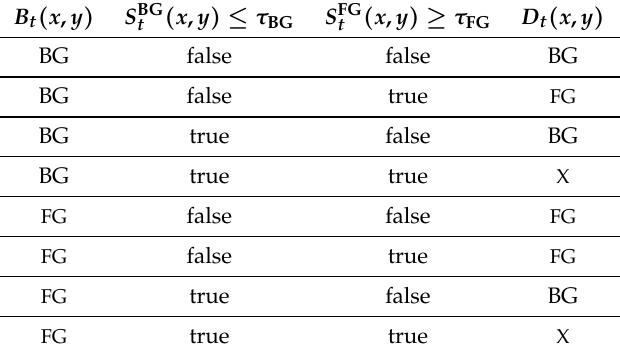
Table 2. Decision table as implemented by SBS. Rows corresponding to “don’t-care“ values (X) cannot be encountered, assuming that τ BG < τ FG